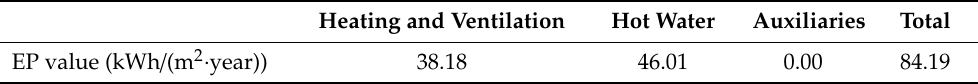
Table 23. The annual EP demand (kWh / (m 2 · year)) for the multi-family building at Akacjowa Street in Goleniow (district heating (Goleniow) + application of photovoltaic installation to supply auxiliary equipment and part of the energy for the preparation of the hot water).